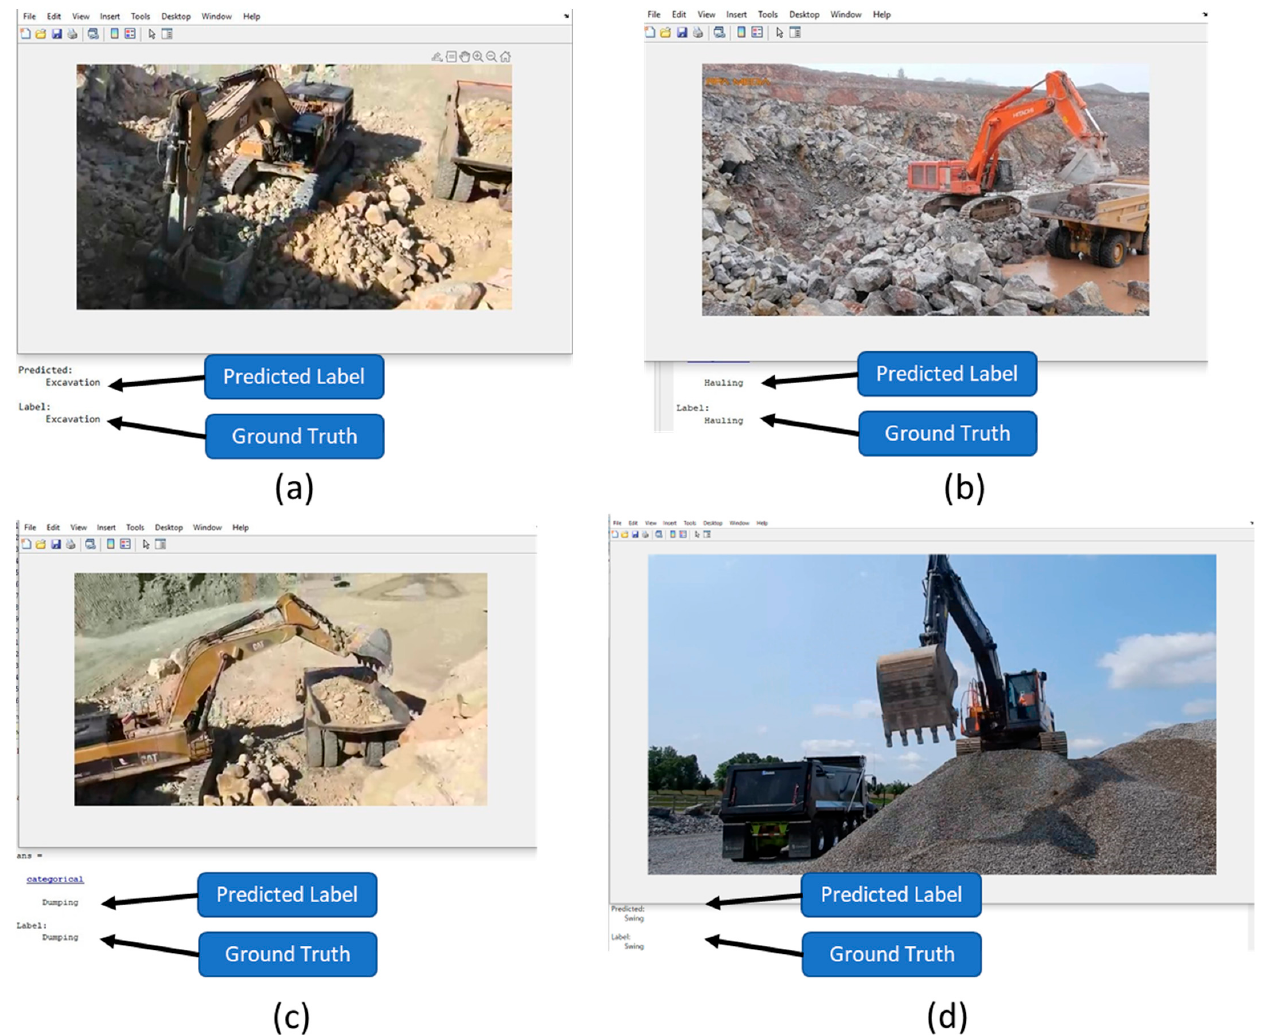
Figure 9. Example of successful activity recognition from the test dataset ( a ) Excavation ( b ) Hauling ( c ) Dumping ( d ) Swing.